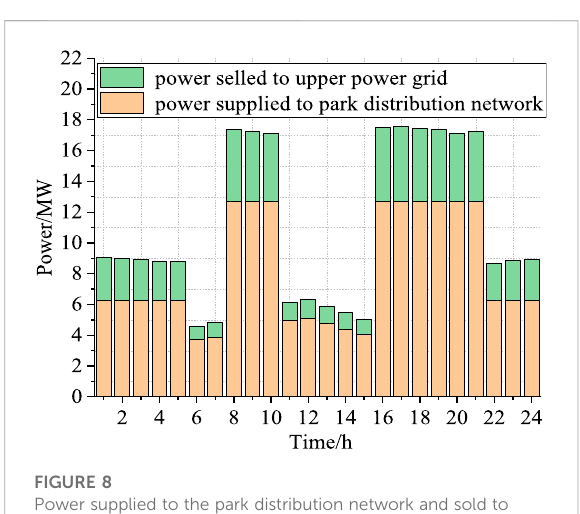
FIGURE 8 Power supplied to the park distribution network and sold to the upper power